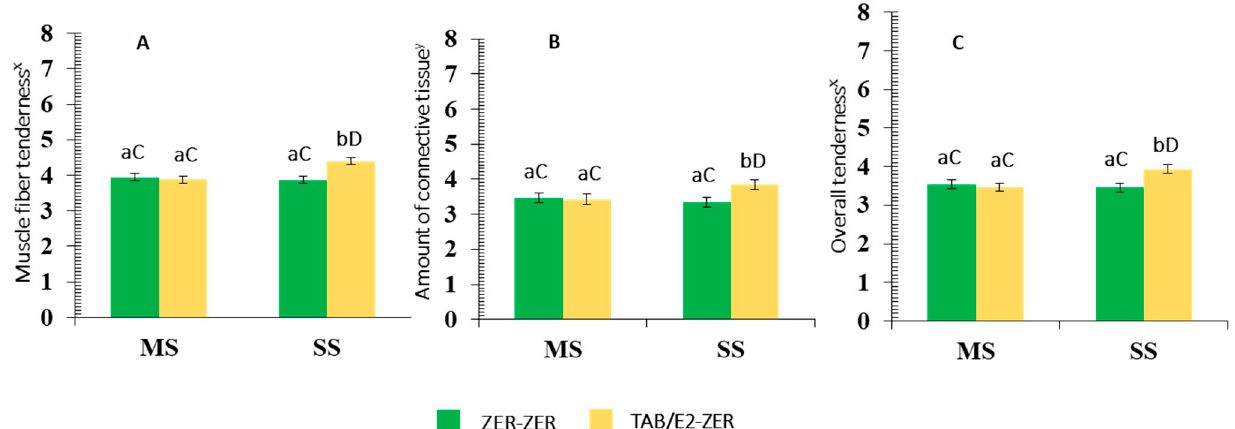
Figure 1. Mean values ± standard error for pasture supplementation (SUPPL) × implant protocol (IMPL) interaction ( p = 0.02) for muscle fiber tenderness ( p < 0.01; A ), for connective tissue ( p < 0.01 B ), and overall tenderness ( p = 0.02; C ). Panelist ratings for bull meat ( X 1 = extremely tough and 8 = extremely tender. Y 1 = abundant amount of connective tissue, 8 = no connective tissue). SUPPL: SS: strategic supplementation; MS: only mineral supplementation as a control treatment. IMPL: ZER ‐ ZER: corresponds to a dose (72 mg) of zeranol at d ‐ 0 followed by a second identical dose at d ‐ 90; TBA/E2 ‐ ZER: corresponds to a first dose containing 140 mg trenbolone acetate + 20 mg estradiol 17 β at d ‐ 0, followed by a second dose of zeranol (72 mg) at d ‐ 90. Bars with a common superscript lowercase letter (a, b) for IMPL treatments within the same SUPPL treatment do not differ ( p > 0.05). Bars with a common superscript uppercase letter (C, D) for SUPPL treatment within the same implant treatment, do not differ ( p > 0.05).